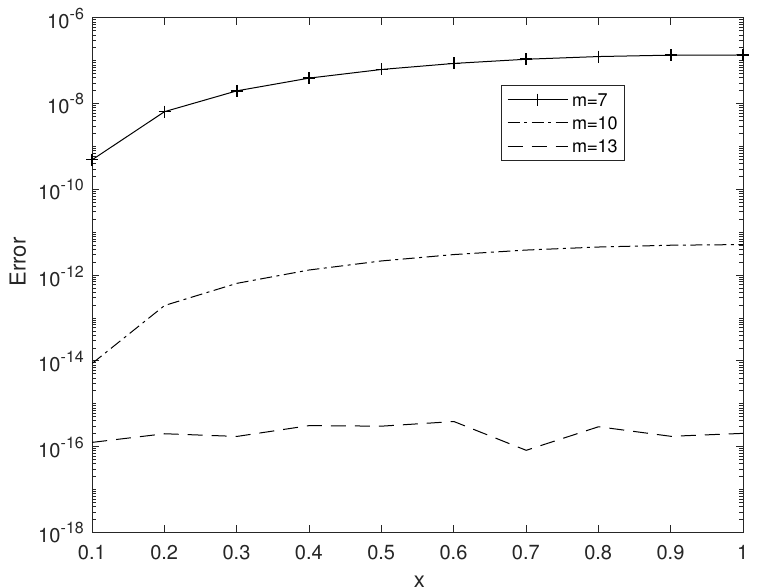
Figure 4. Approximation errors ( h = 0.1) for the matrix problem (34) with distinct spline